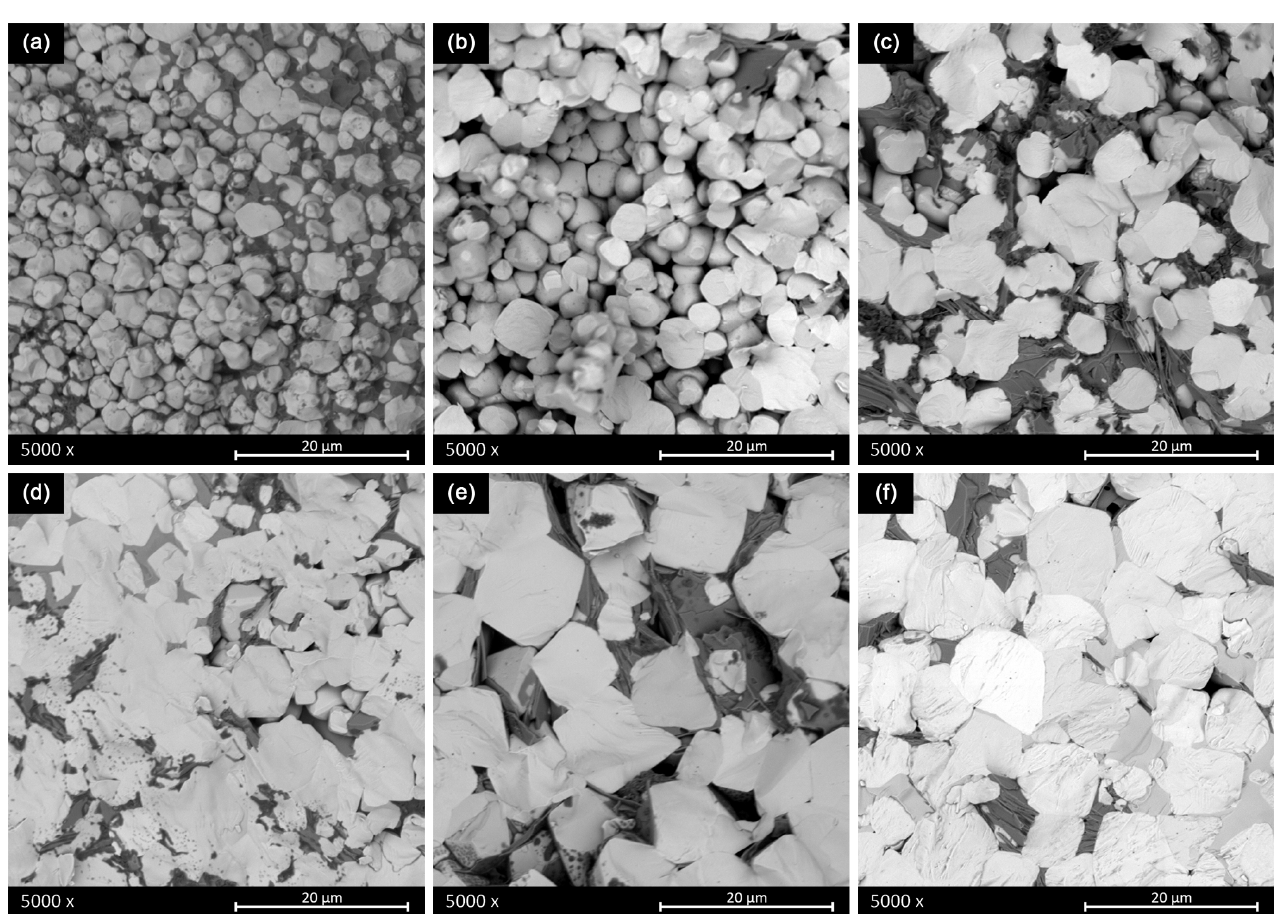
Figure 7. Scanning electron micrographs of the sintered ceramics obtained from powder calcined at 700 °C for 30 min, and subsequent sintering of the pellets at different sintering times and temperatures, using a single sintering plateau: ( a ) 1150 °C for 1 h, 1 BM ( b ) 1260 °C for 30 min, 1 BM, ( c ) 1260 °C for 30 min, 2 BM ( d ) 1280 °C for 2 h, 2 BM, ( e ) 1280 °C for 4, 2 BM and ( f ) 1300 °C for 4 h, 2 BM.